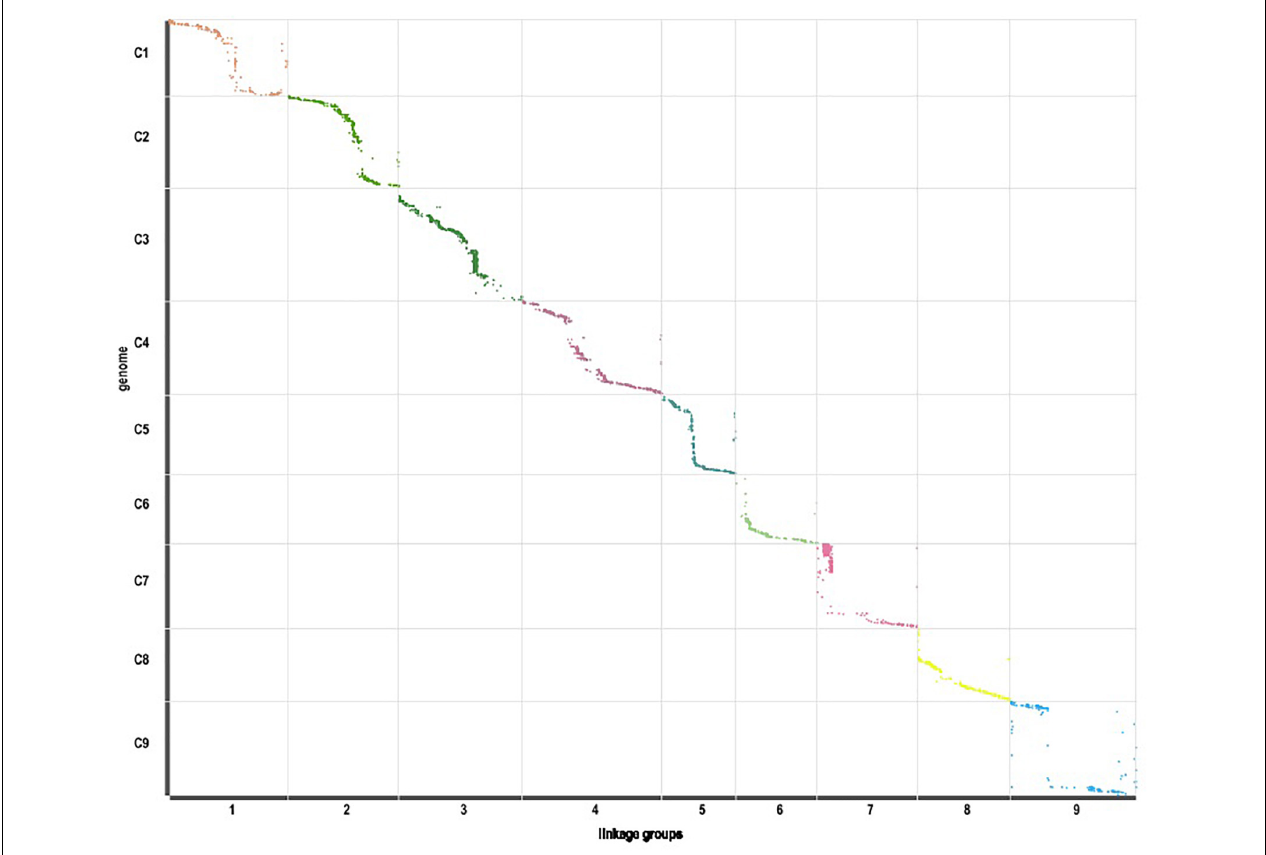
FIGURE 6 | Linearity comparison between the markers in the genetic map and sequences in nine pseudo-chromosomes of TO1000 genome.